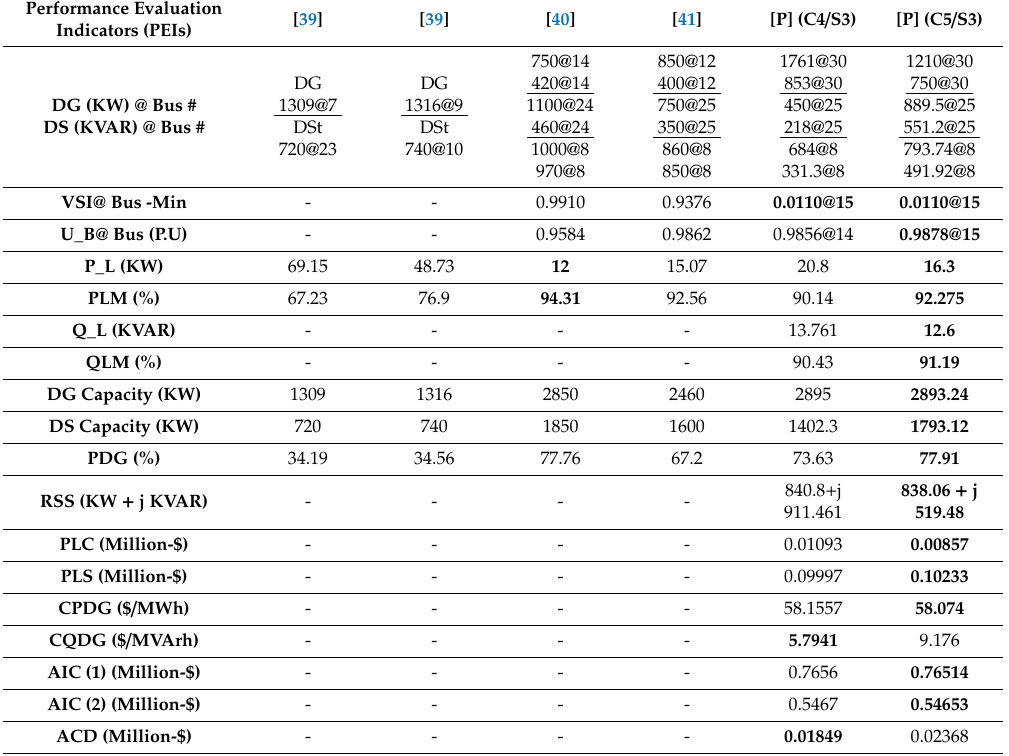
Table 14. Comparisons of results with various scenarios of cases 4 and 5 (DG + DSt) for 33-bus test